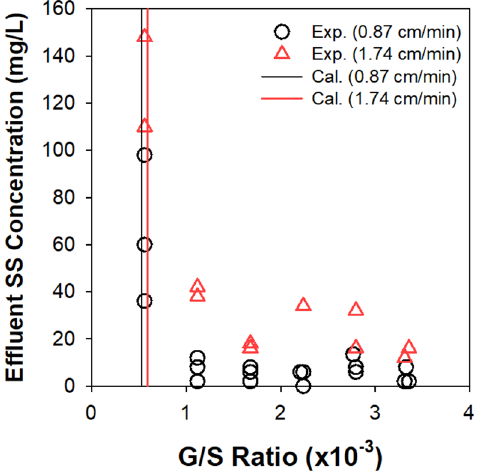
Figure 6. Limiting G/S ratio as a function of influent v for individual bio-particles with variable sizes.